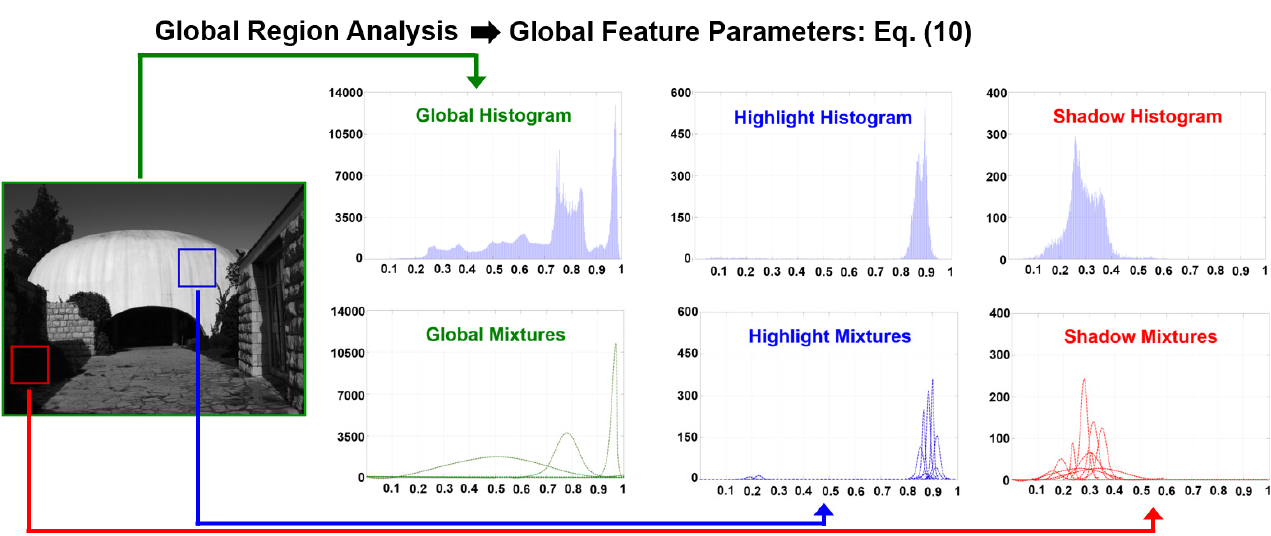
Figure 4. Proposed mutually hybrid histogram analysis approach. We analyze the global and local histograms simultaneously using different statistical methods, i.e., Gaussian mixture model for the former and stratified sampling for the latter. Although different statistical methods are applied, we aim to extract the mutually compatible features to form a virtual combined histogram (introduced later in Section 3.4).